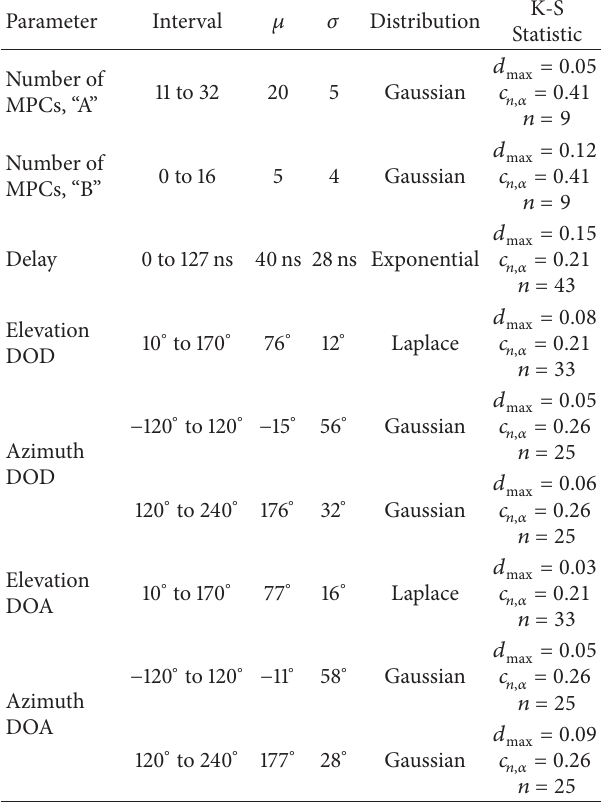
Table 3: Marginal distribution of